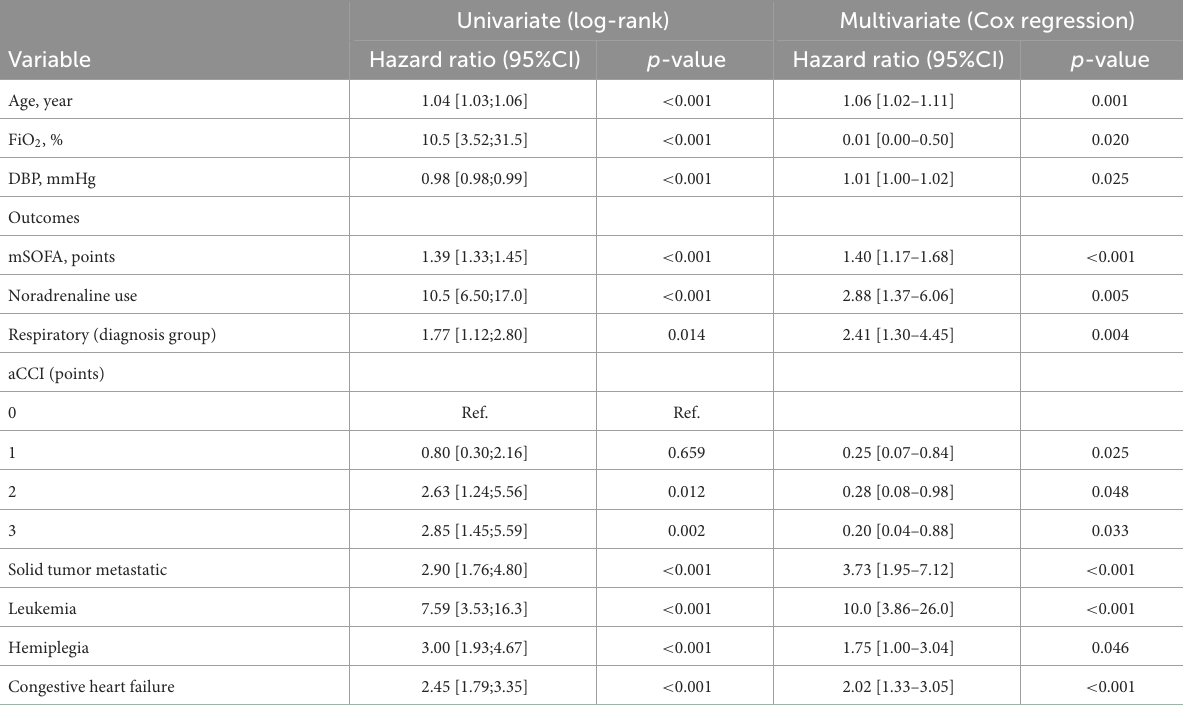
TABLE 6 Factors associated with mortality (univariate and multivariate by Cox regression) for those patients with